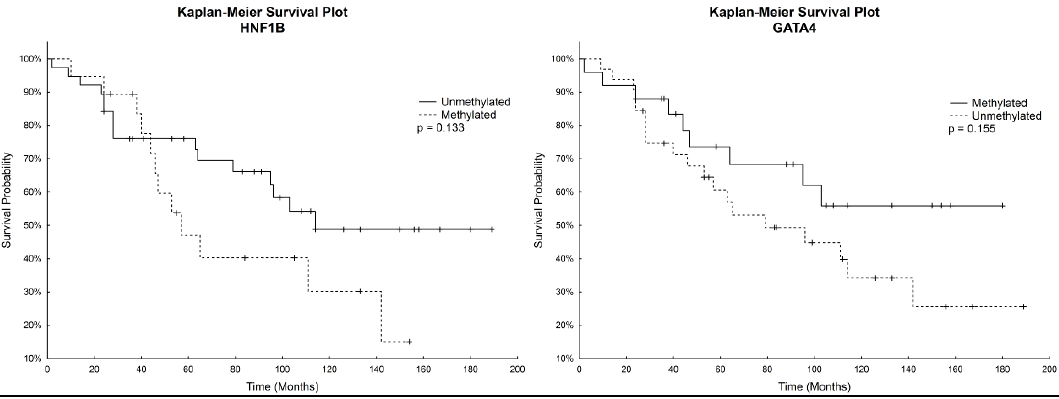
Figure 3. Survival probability of patients with methylated or unmethylated HNF1B and GATA4 .